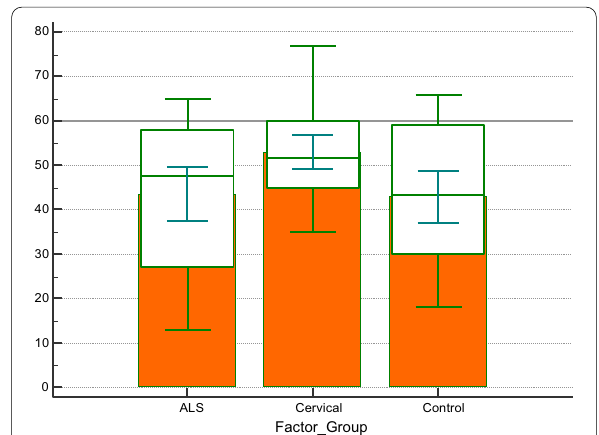
Fig. 2 Comparison between three groups regarding age